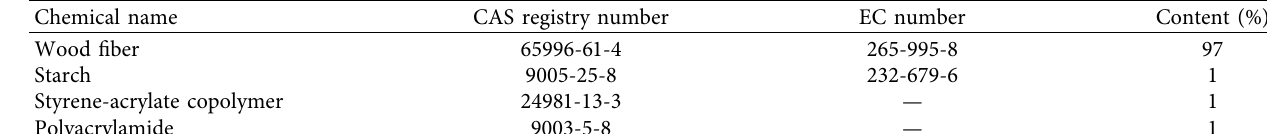
Table 4: Chemical constituents of the first-class kraft faced liner.